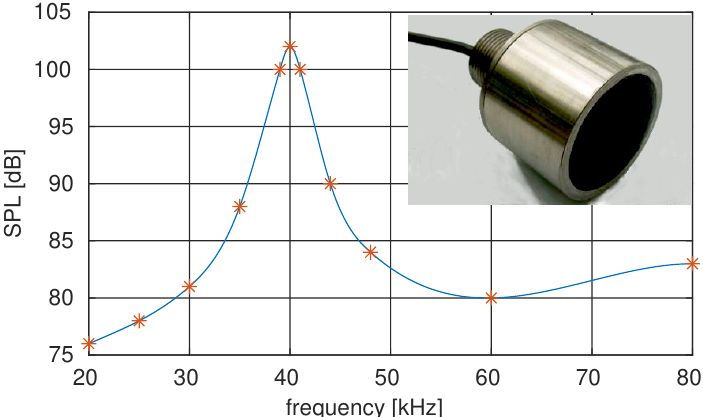
Figure 5. A photo and frequency characteristic of the sound pressure level of the ultrasonic transducer used in the